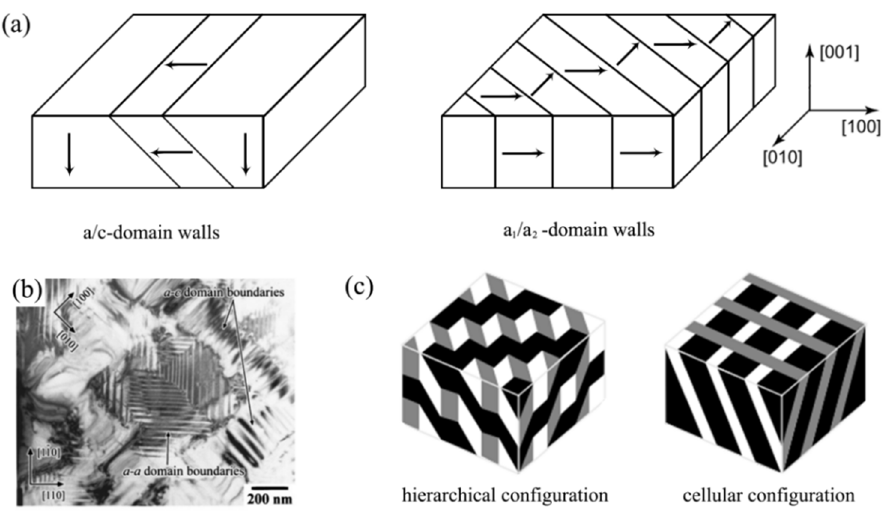
Figure 7. Domain configurations in tetragonal PTFs. ( a ) Schematic diagrams of domain walls in tetragonal PTFs: a/c-domain walls (left) and a 1 /a 2 -domain walls (right). The arrow indicates the polarization direction of different domain. ( b ) Experimental observation of domain walls in tetragonal PTFs. Reprinted with permission from [108] 2001 AIP Publishing; Two types of domain walls are observed, as indicated by the arrows. ( c ) Schematic diagrams of three domain configurations in tetragonal PTFs: hierarchical configuration (left) and cellular configuration (right). Reprinted with permission from [107] 2010 Springer Nature.